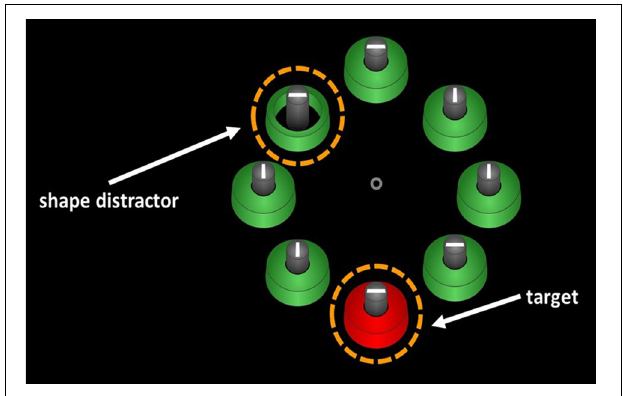
FIGURE 1 | An illustration of the procedure of Goller et al. (2020), Experiment 4. Korean- speaking and German-speaking participants had to search for a color-defined target (e.g., a red target as depicted), and a fit-singleton distractor (e.g., a loose-fit ring among tight-fit rings) was presented away from the target in half of the trials. Compared to a condition without spatial-fit distractor, Korean speakers but not German speakers showed slower search performance for the color targets. This is in line with linguistic relativity, as search for the targets was delayed by stimulus-driven capture of attention toward the spatial-fit singletons only among the Korean speakers that verbally discriminate between tightness of fit levels in an obligatory way, but not among the German speakers that do not have to verbally discriminate different